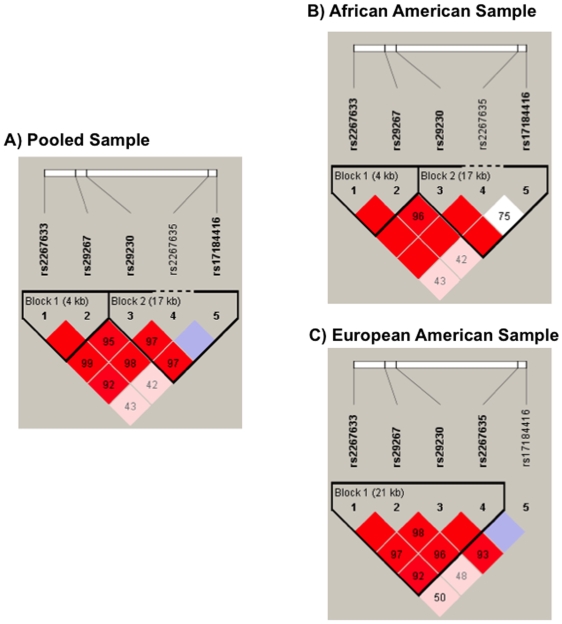
Linkage disequilibrium map of six SNPs within GABBR1 in pooled, African-American, and European-American samples.Dark red denotes high linkage disequilibrium (LD) (D′ = 1 and LOD >2). Lower LD values are represented in shades of pink (0.21<D′<1 and LOD >2). White represents low LD and low LOD (LOD <2). Numbers indicate the D′ statistic for two consecutive SNPs. LD blocks were defined using Haploview [25].